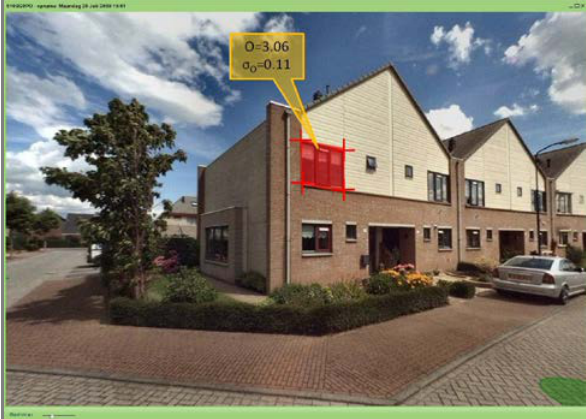
Figure 7. Example of line measurement in a single image